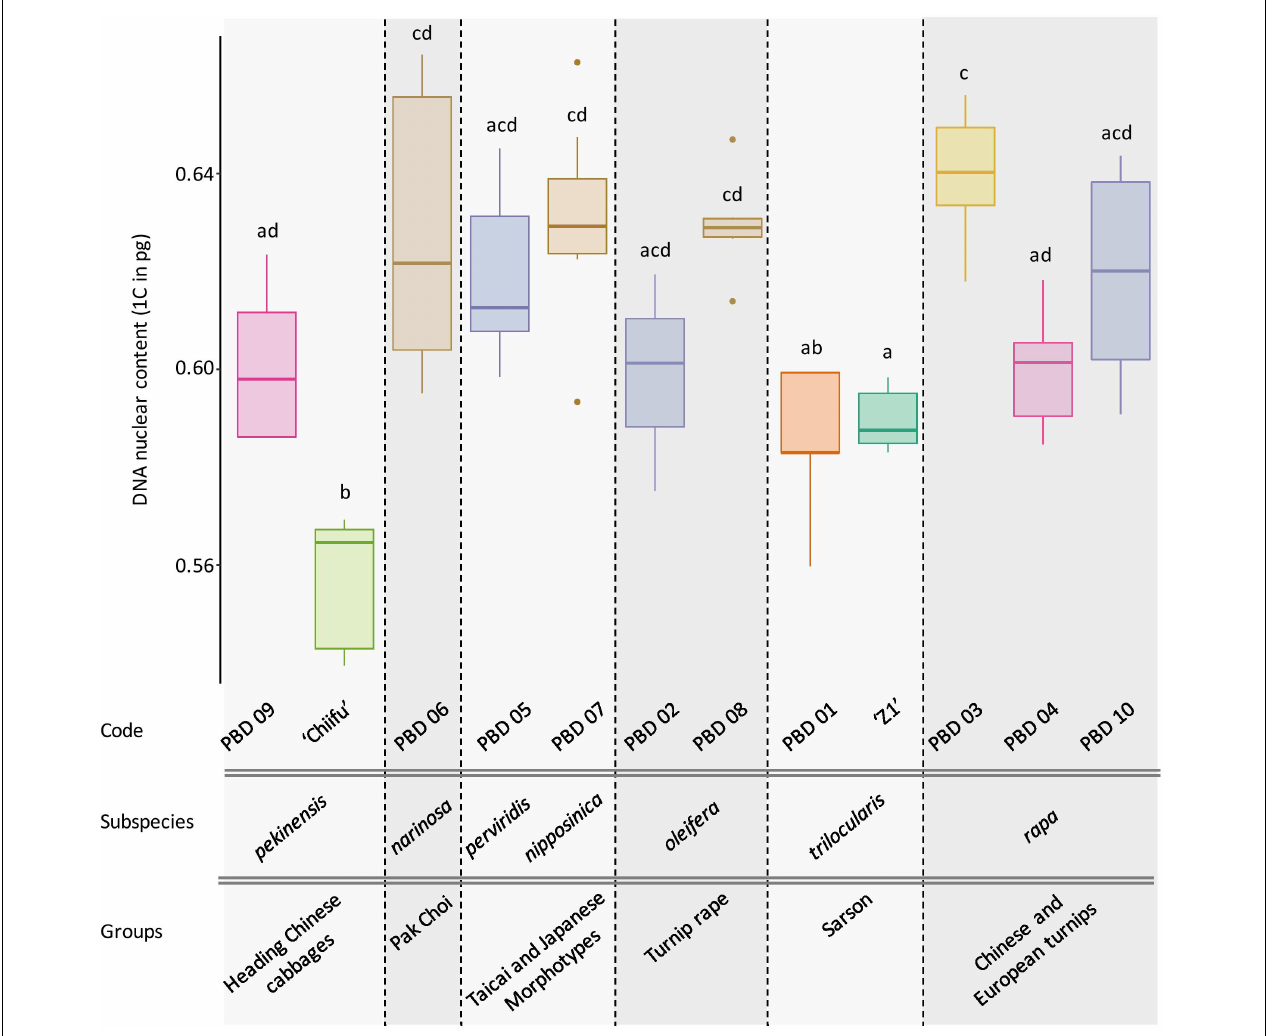
FIGURE 6 | Box plot of the DNA nuclear content (1C) of 12 B. rapa accessions with 5 to 10 individuals per accession. Colors indicate the Tukey pairwise comparisons and group assignment (Tukey HSD; α = 0.05). Accessions are classified according to their higher-order phylogeny (group and subspecies according to Cheng et al.,